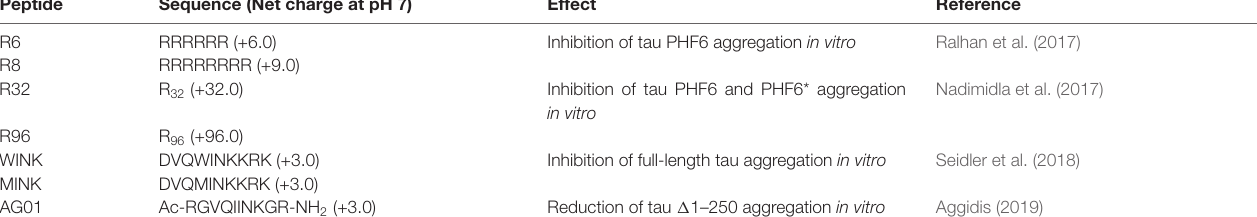
TABLE 2 | Polyarginine and arginine-rich peptides with modulatory effects on tau aggregation. Peptide Sequence (Net charge at pH